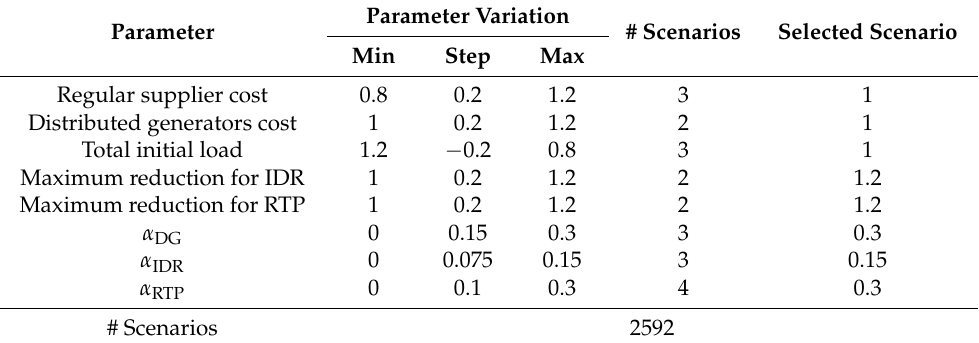
Table 1. Scenarios